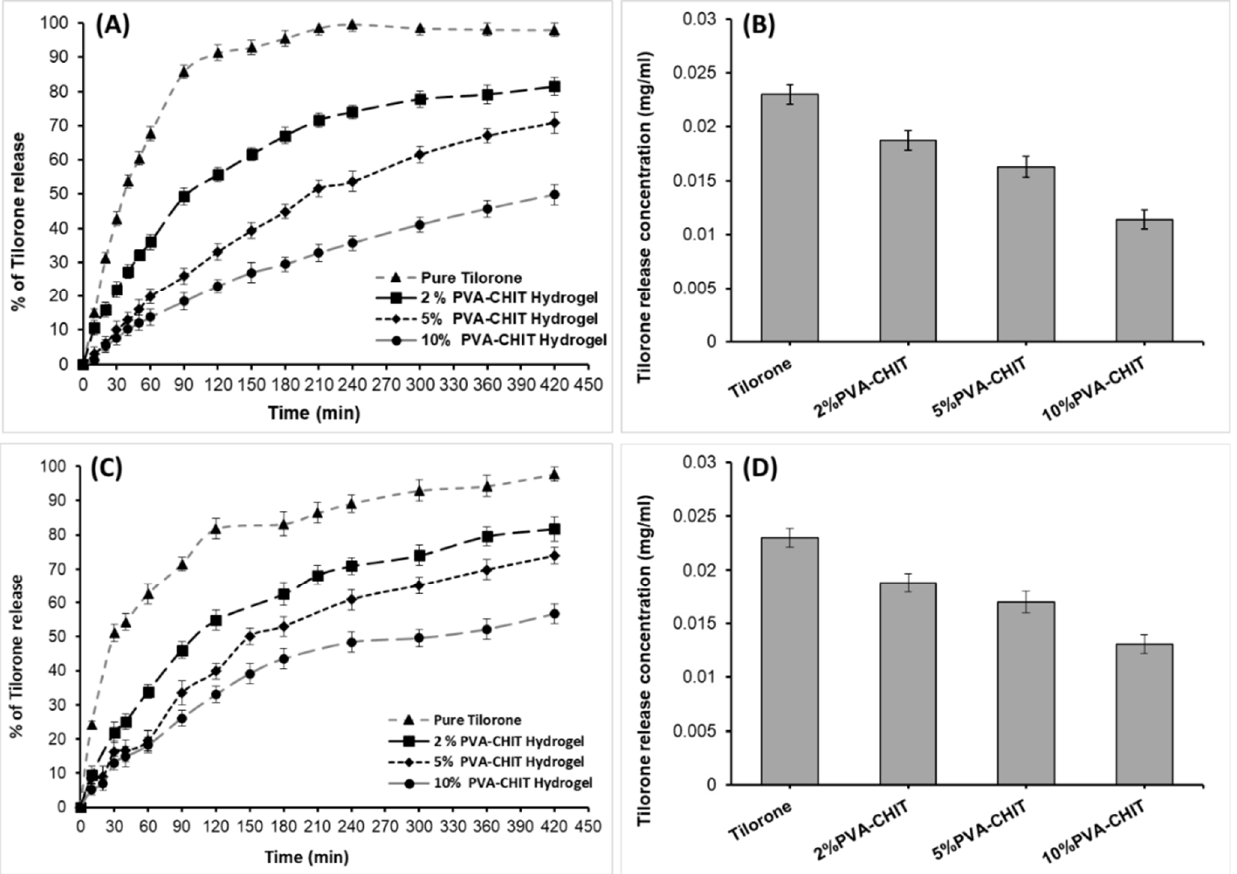
Figure 10. ( A ) In vitro release of tilorone dihydrochloride from its pure form and from different hydrogel (2, 5, and 10% w / v ) concentrations, ( B ) the maximum releasing concentration (mg/mL) of tilorone from its pure drug form and from (2, 5, and 10% w / v ) PVA-CHO/CHIT-SH hydrogels, ( C ) in vitro release of tilorone dihydrochloride from its pure form and from different hydrogel (2, 5, and 10% w / v ) concentrations in the presence of lysozymes, and ( D ) the maximum releasing concentration (mg/mL) of tilorone from its pure drug form and from (2, 5, and 10% w / v ) PVA-CHO/CHIT-SH hydrogels in the presence of lysozymes. Table 1. Interpretation of the release experiments using different kinetic models.